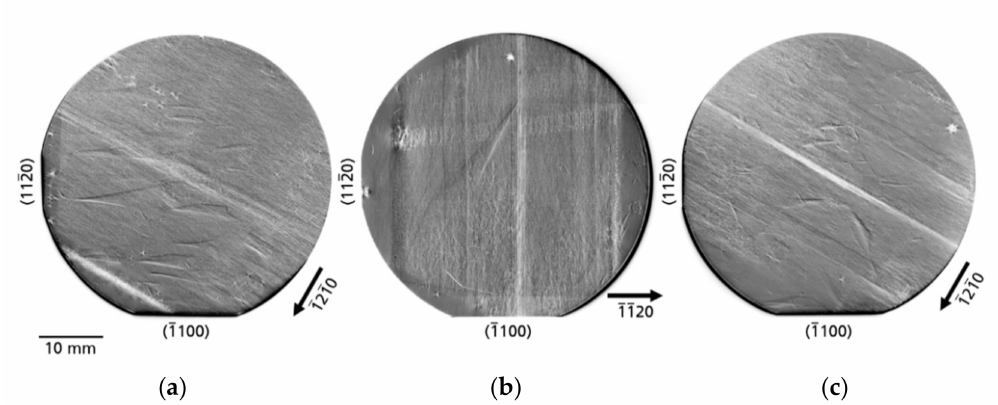
Figure 2. XRT overview topographs of the three investigated substrates: ( a ) substrate A, ( b ) substrate B, and ( c ) substrate C. For the imaging type 1120 reflections were used.